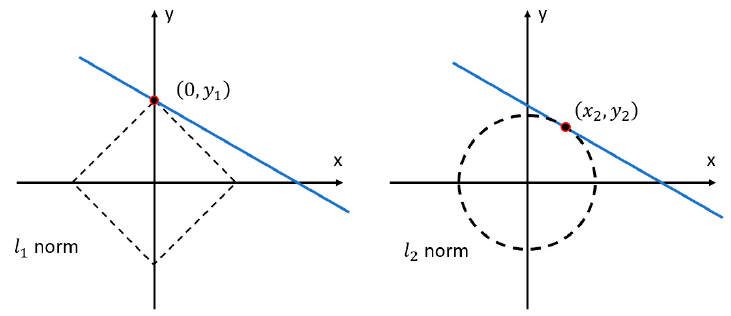
Figure 1. l 1 and l 2 norm solutions for the linear underdetermined problem.